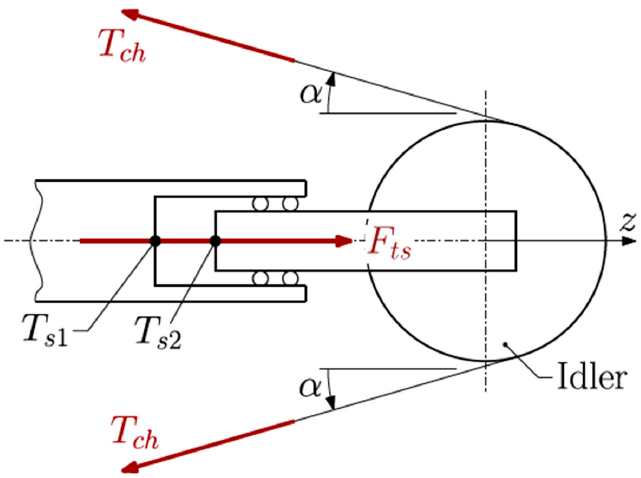
Figure 9. Scheme of the track belt